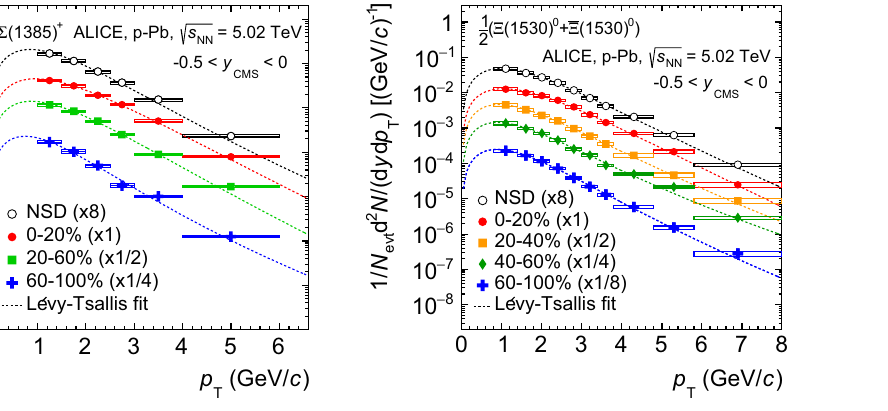
Fig. 5 Transverse momentum spectra of (cid:3) ∗+ ( left ) and (cid:4) ∗ 0 ( right ) in different multiplicity classes in the rapidity range − 0 . 5 < y CMS < 0. For (cid:4) ∗ 0 , both particles and antiparticles are analysed together. Statisti-